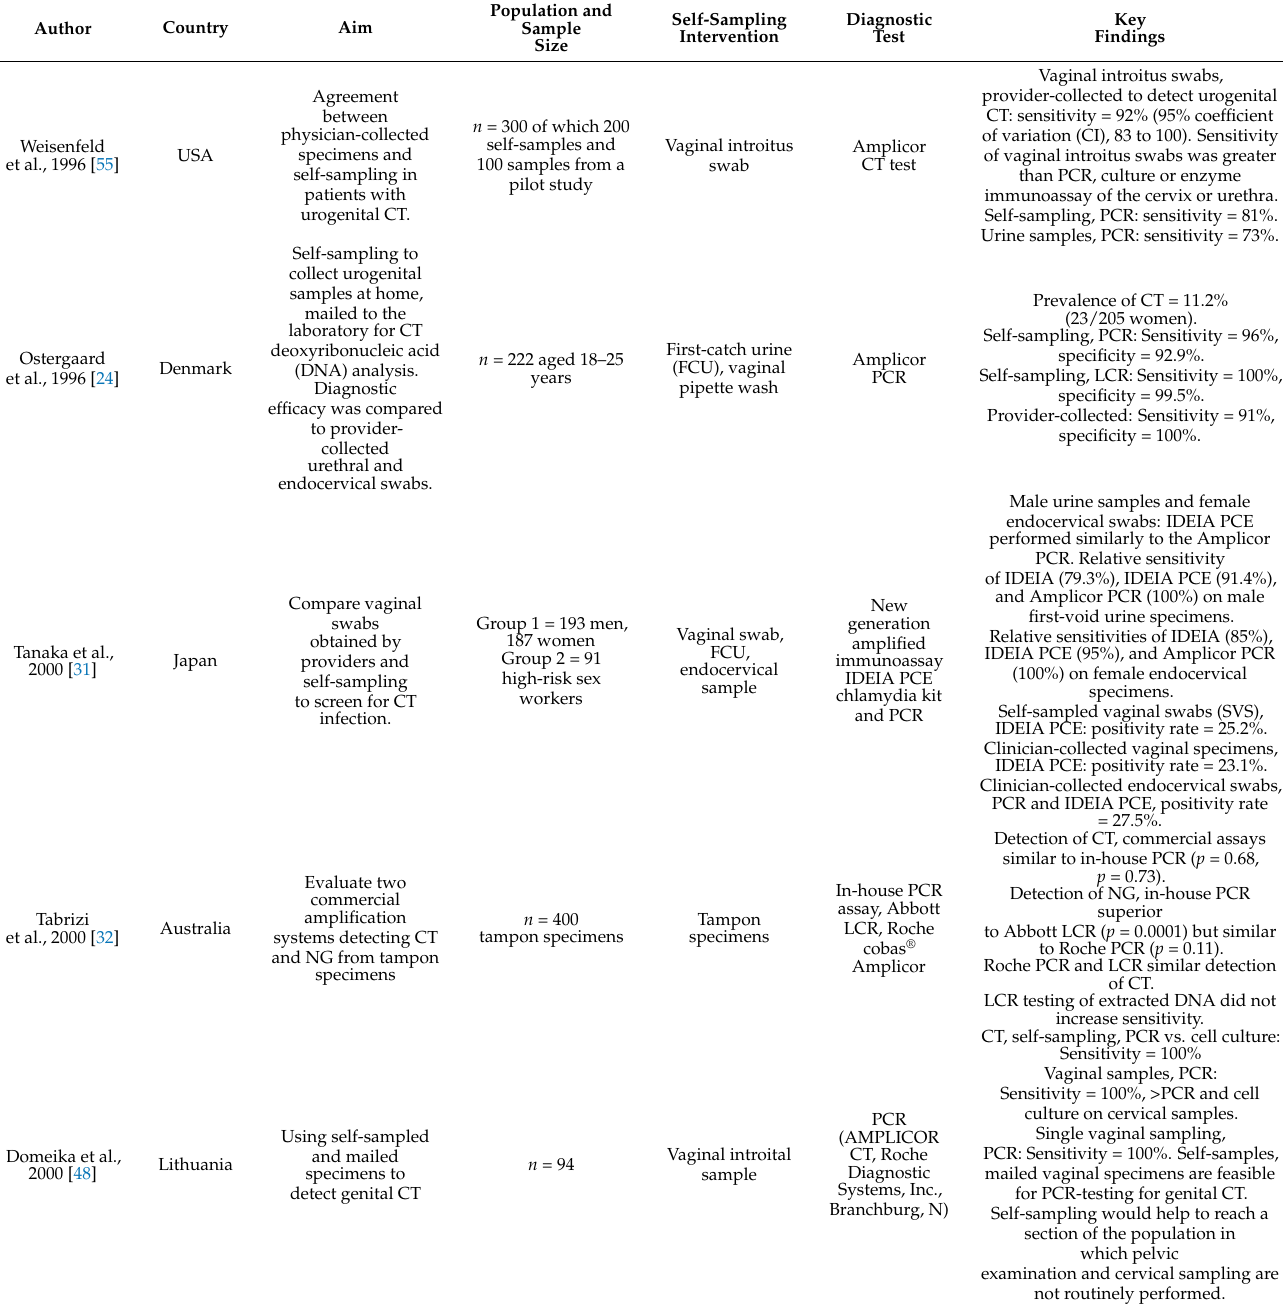
Table 3. Summary of articles included in this scoping review on self-sampling interventions for diagnosing STIs in